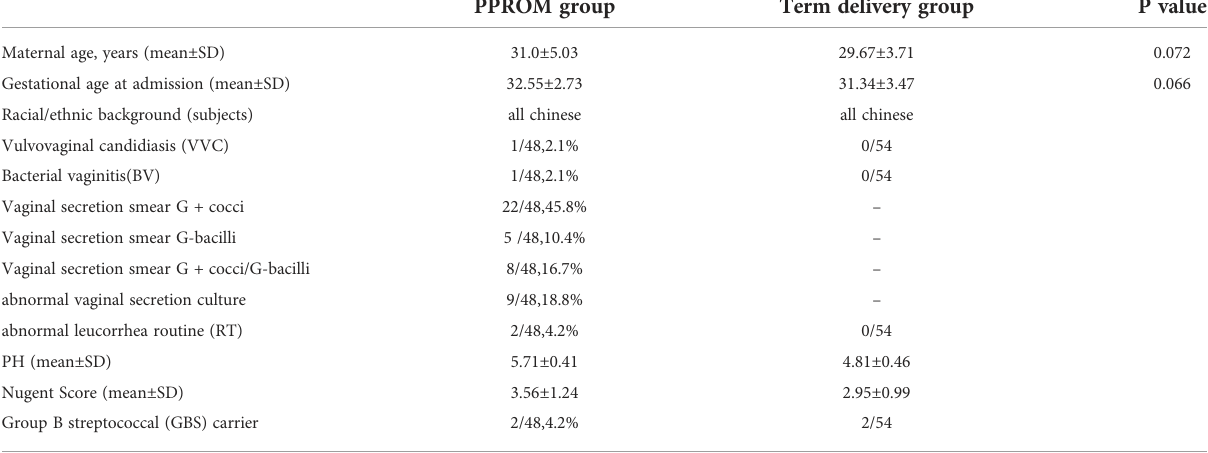
TABLE 1 Clinical characteristics of the study